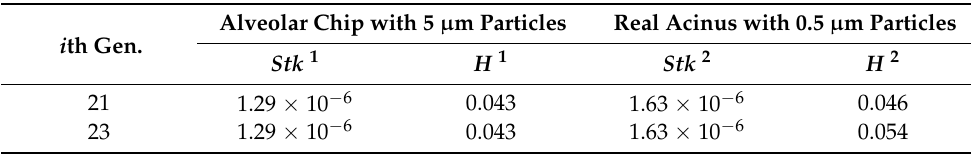
Table 1. Comparison of dimensionless numbers for